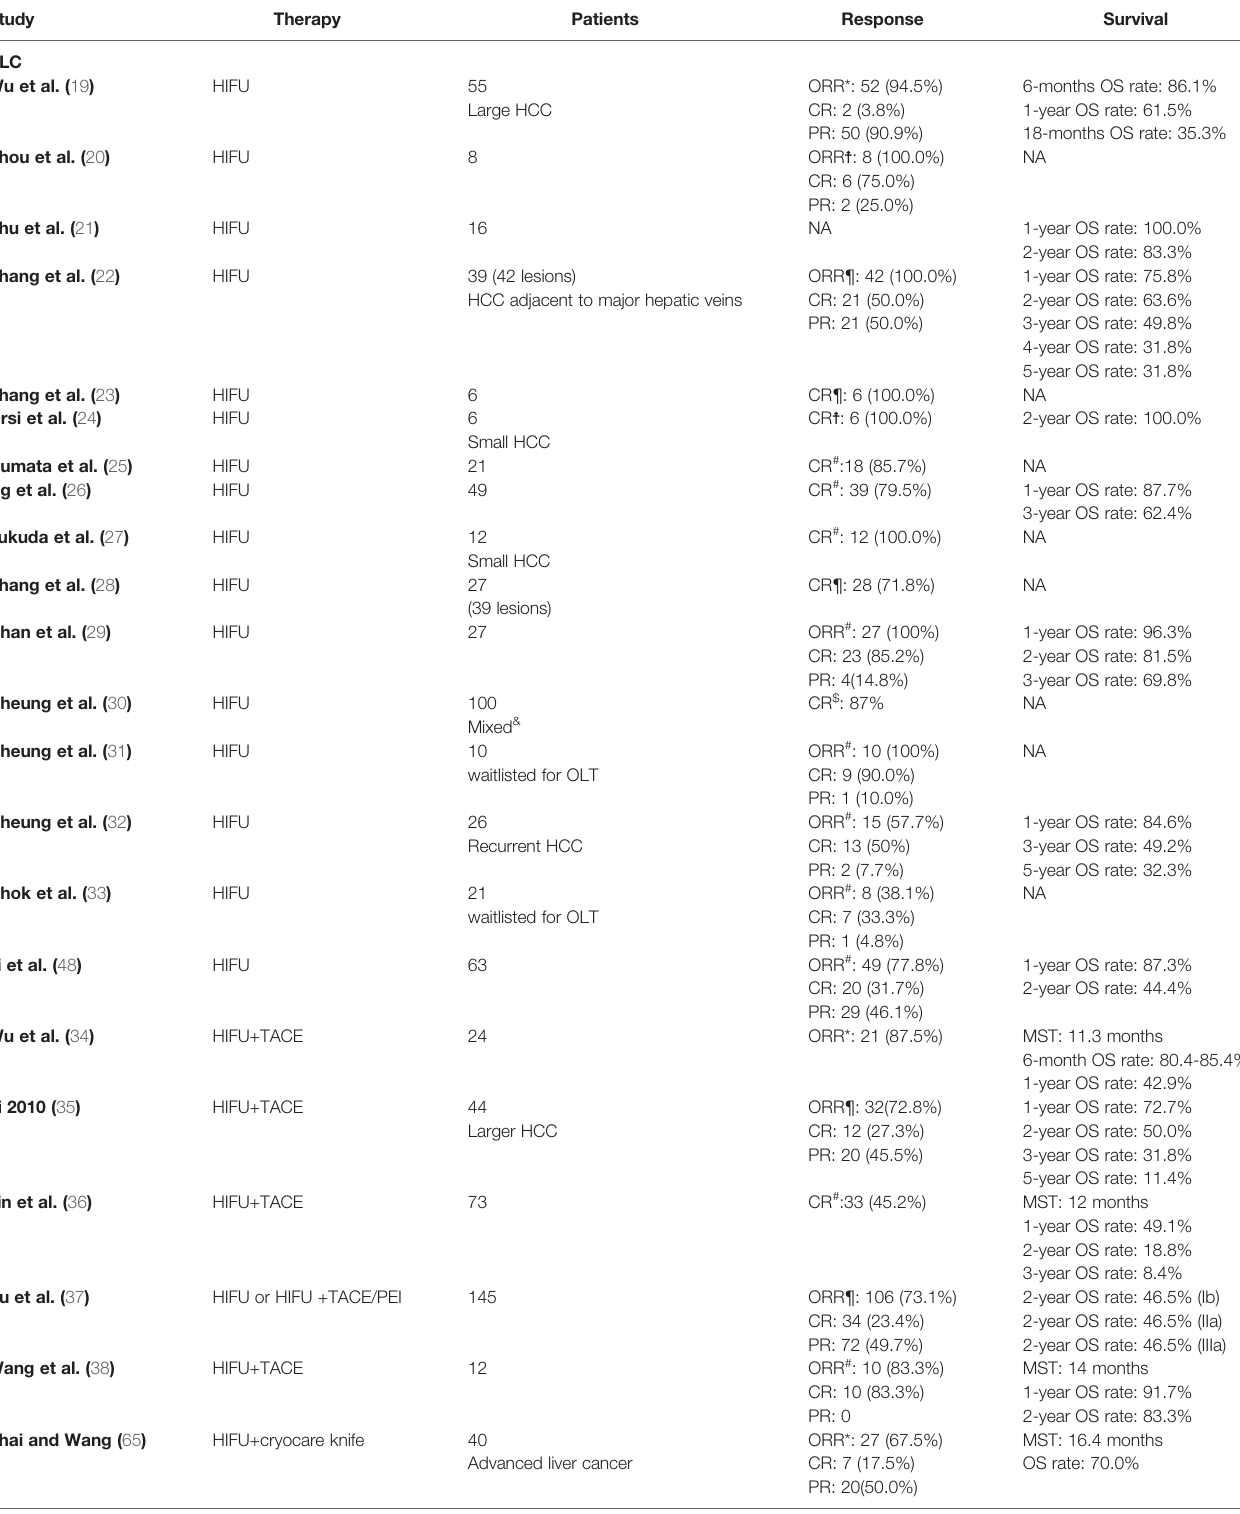
TABLE 5 | Summary of previous data on HIFU ablation for primary and secondary liver